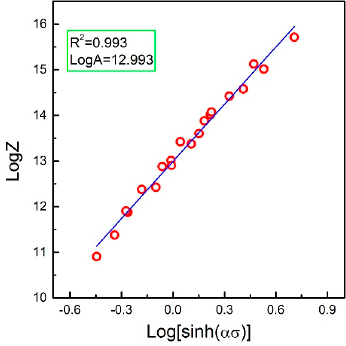
Figure 6. Correlation between log[sinh( ασ )] vs. log Z under different working conditions.